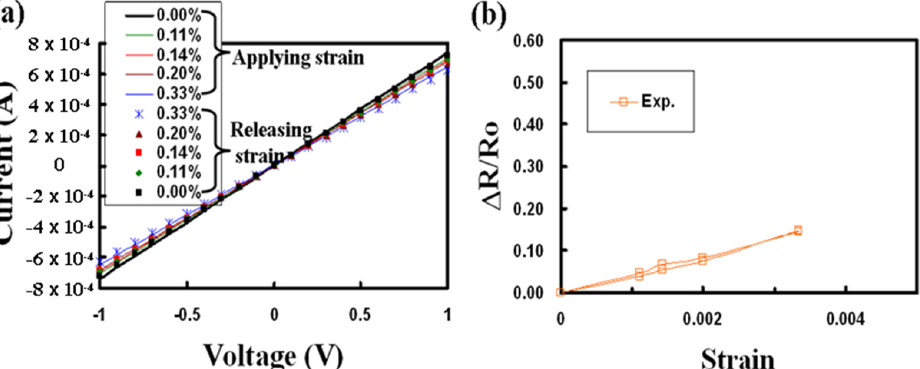
Figure 4. ( a ) I ‐ V characteristics of the + ‐ shape flexible PR strain sensor measured with one full cy ‐ cle of applying various å values from 0% to 0.33% and then releasing various ε values from 0.33% to 0%. The solid lines and symbols denote one full cycle of applying and releasing strain, respec ‐ tively. ( b ) The relation between normalized resistance change ( Δ R / R 0 ) and applied ε with one full strain cycle corresponding to Figure 4a.